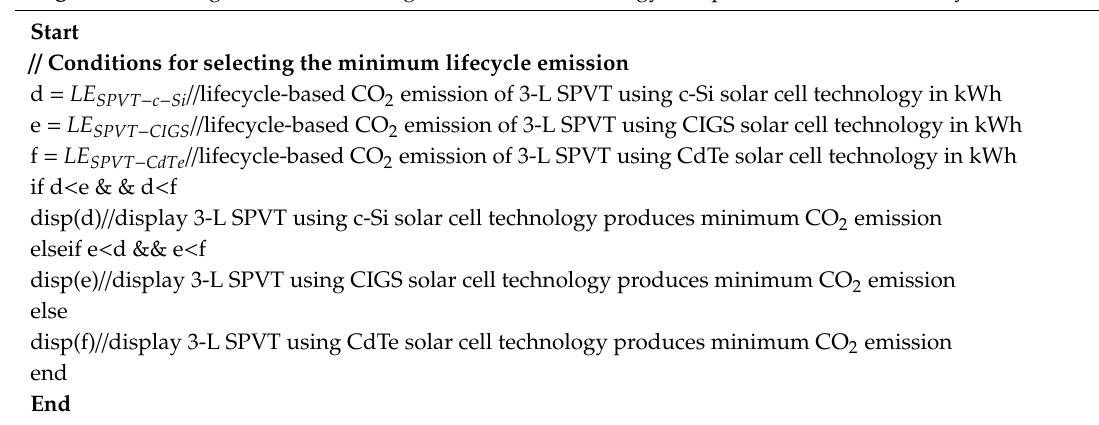
Algorithm A3: Algorithm for selecting the solar cell technology that produces minimum lifecycle